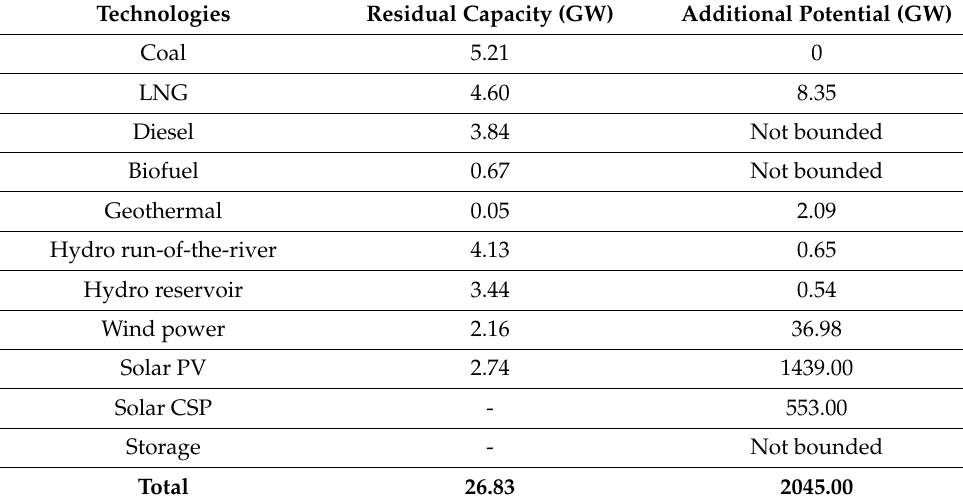
Table 2. Residual capacity and potentials, in GW, for the different generation technologies.